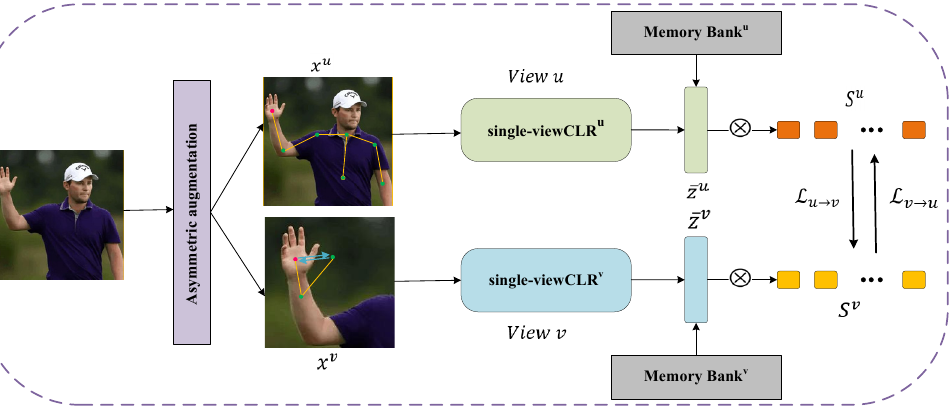
Figure 3. Composite framework based on asymmetric data augmentation strategy. ⊗ denotes the dot product.